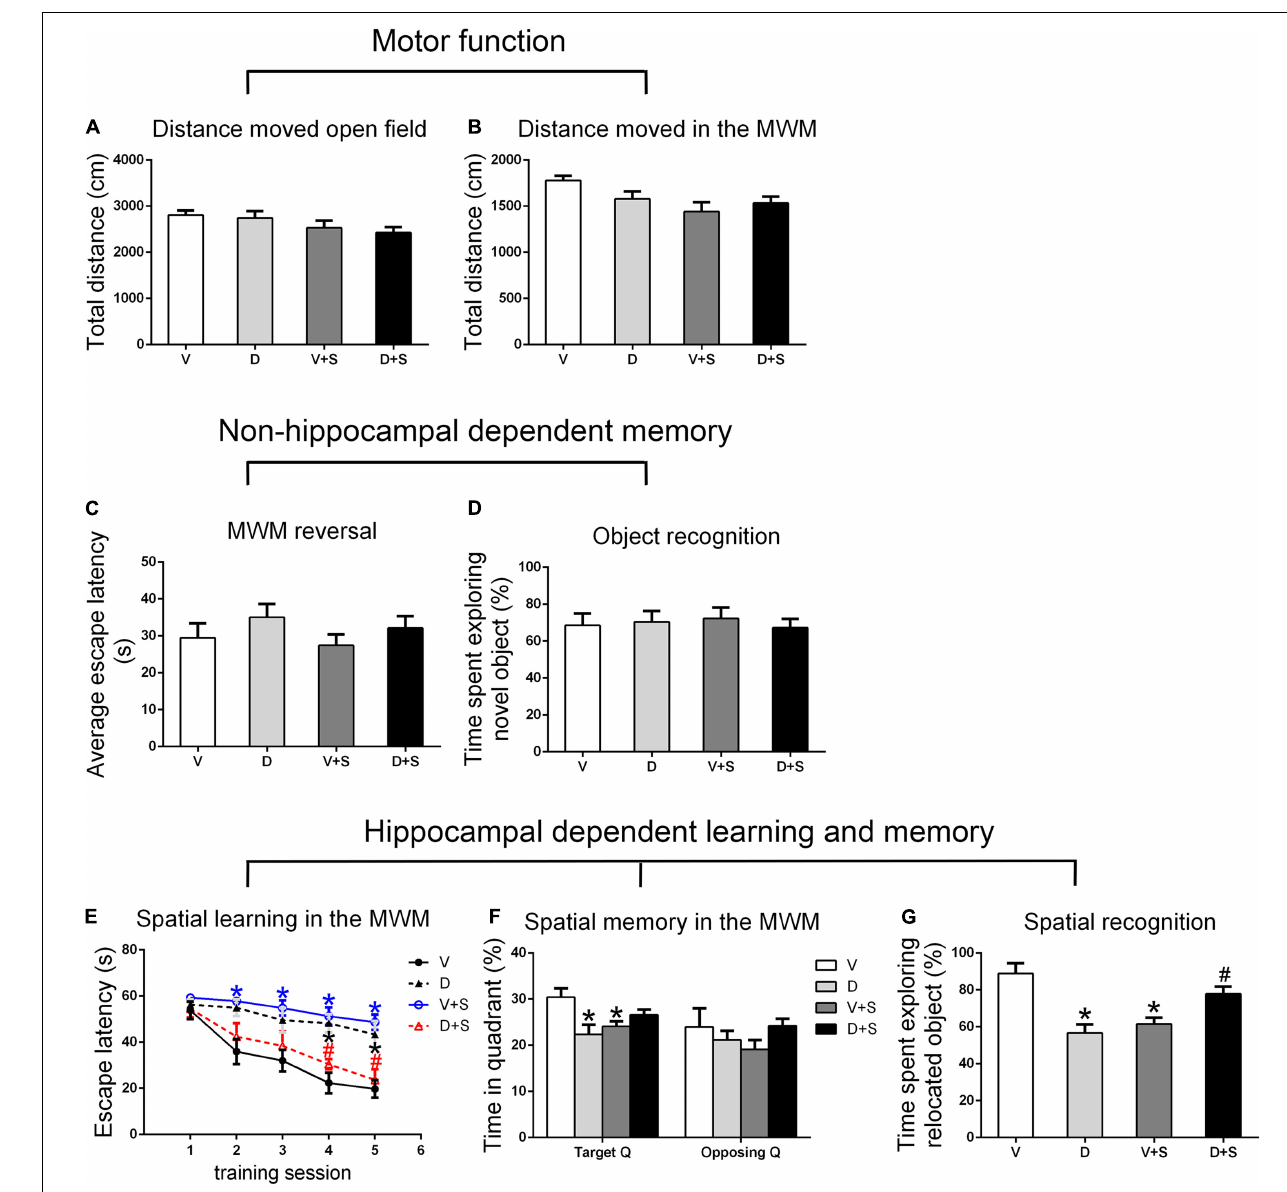
FIGURE 3 | Open field behavior, learning, and memory performance in the four groups 1 week postoperatively. (A) Distance moved in the open field test (cm). (B) Distance moved (cm) in the Morris water maze (MWM) during the first test as a measure of motor function. (C) Cognitive flexibility in the MWM. Average escape latency (s) during the four MWM reversal trials. (D) Object recognition in the novel object (NO) test. (E) Spatial learning in the MWM. Average escape latency (s) is shown for the five training sessions in the maze. (F) Spatial memory in the MWM. The percentages of time in the target quadrant (Target Q) and time in the quadrant opposite to the target quadrant (Opposing Q) are shown. (G) Spatial recognition in the novel location (NL) test. Exploration time of the relocated object as a percentage of total object exploration is shown. The data are presented as the means ± SEM for each group ( n = 10 per cohort). * p < 0.05 compared to Group V, # p < 0.05 compared to Group V + S.